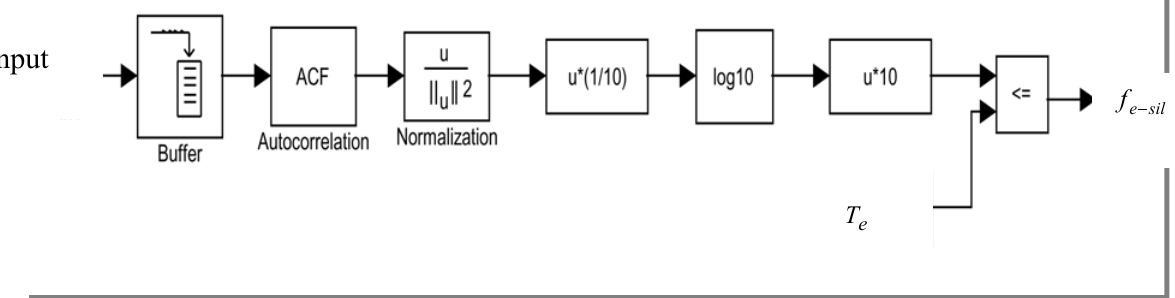
Figure 4. Implementation of the full-band energy